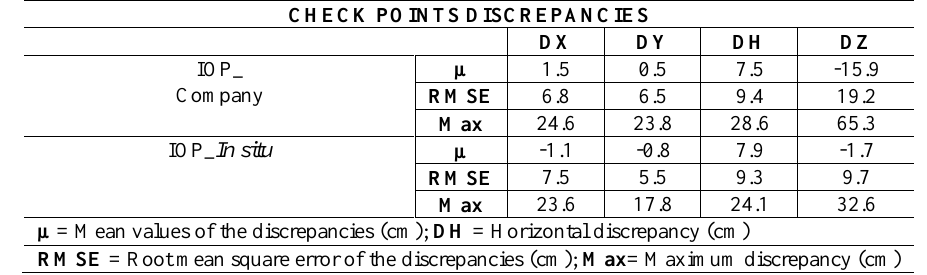
Table 6. Shows the results of discrepancies analysis performed in check points from the ISO experiment of the first block with control points